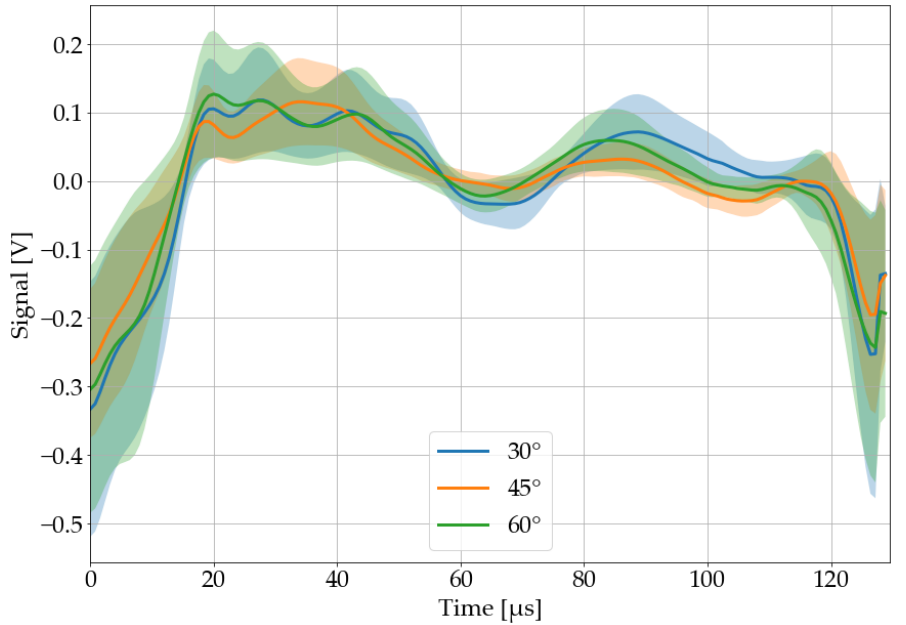
Figure 15. Recorded, processed, and averaged laser-acoustic material responses for black PVC, when the microphone was positioned at different angles. An angle of 0° would be parallel to the material surface, while 90° would be parallel to the laser beam. The colored area around each graph corresponds to its 68% confidence band.